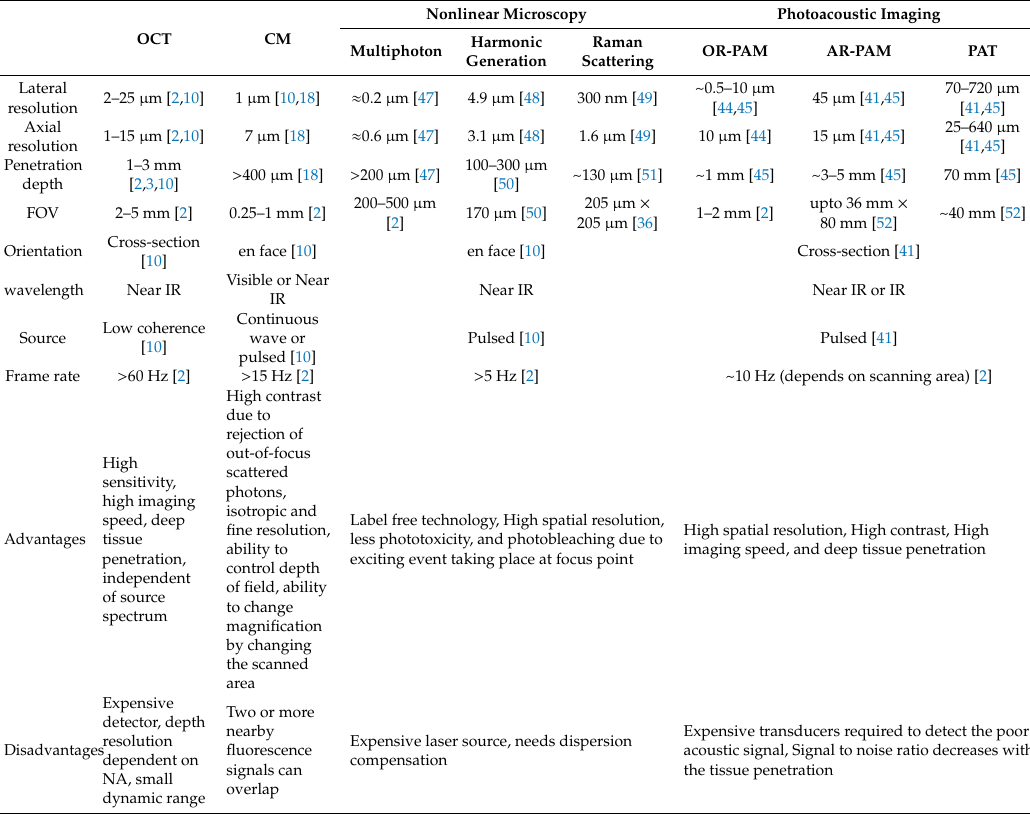
Table 1. Performance of di ff erent imaging applications.